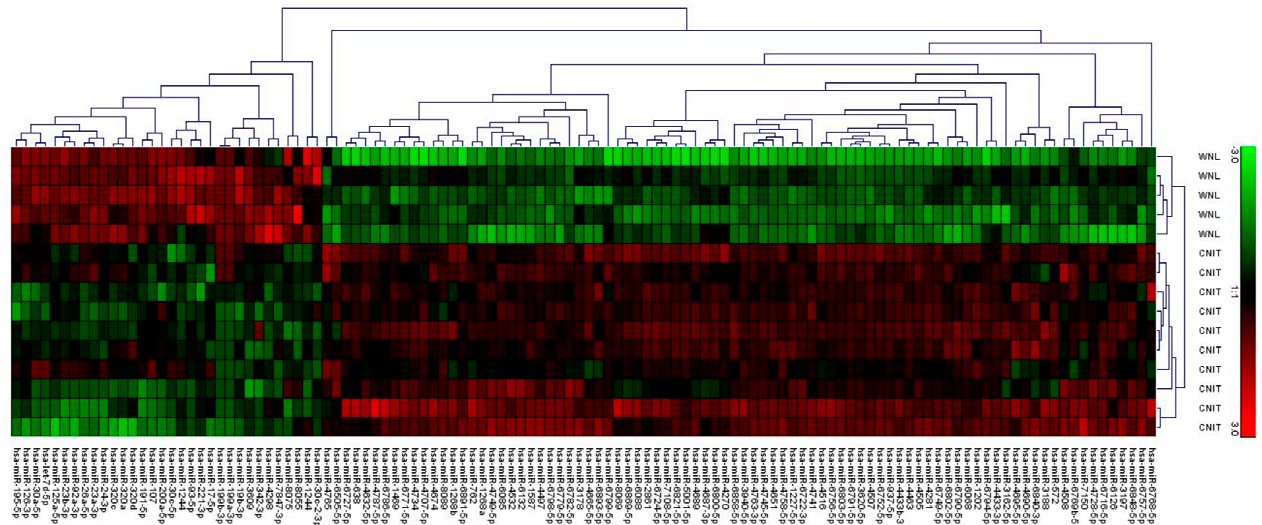
Figure 2. Hierarchical clustering analysis showing differentially expressed microRNAs between Normal (WNL) and CNIT allografts. MiRNA signatures in tissue samples differentiate between histological conditions.